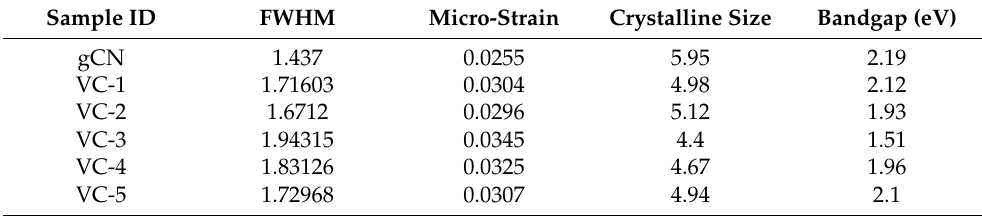
Figure 1. XRD studies for undoped and doped (V and Cu) gCN nanosheets. Table 1. The prepared samples’ FWHM, micro-strain, bandgap, and crystalline Table 1. The prepared samples’ FWHM, micro-strain, bandgap, and crystalline size .